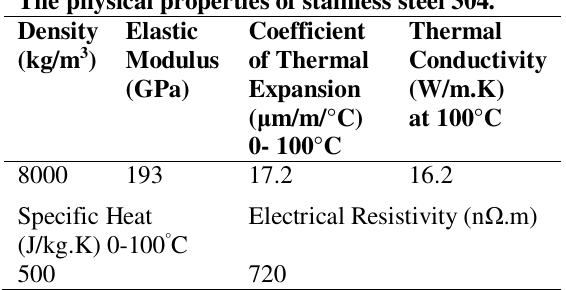
Fig. 2. Fixing the workpiece in the MAF process.